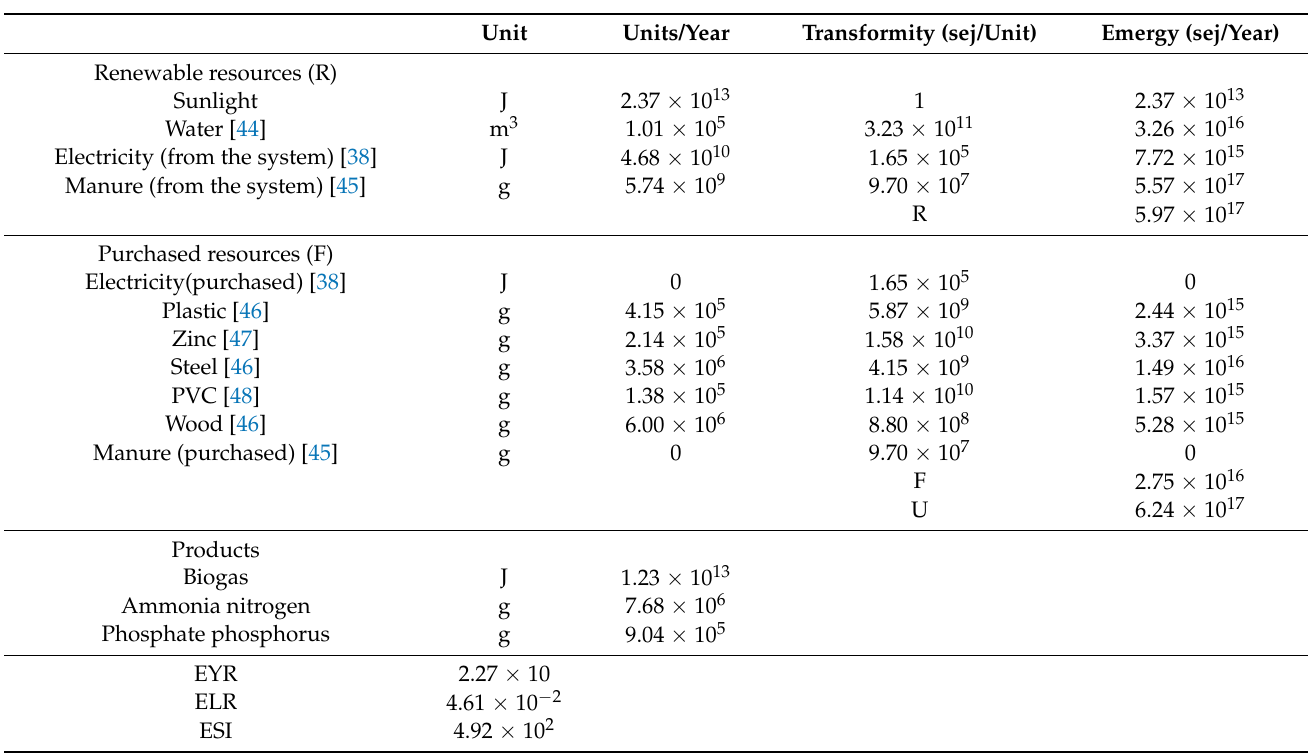
Table 3. Emergy calculation of biogas subsystem